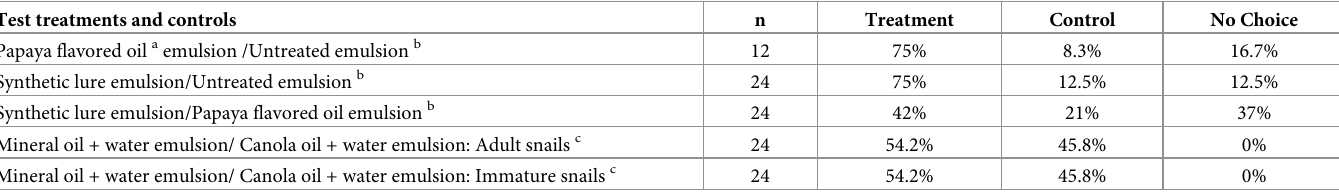
Table 2. The percentage of Lissachatina fulica that selected various test treatments and controls, or made no choice, in two-choice laboratory bioassays testing emulsions of commercial papaya-flavored oil, synthetic reconstructions of the papaya oil odor in canola oil or mineral oil, or water emulsion controls. Test treatments and controls n